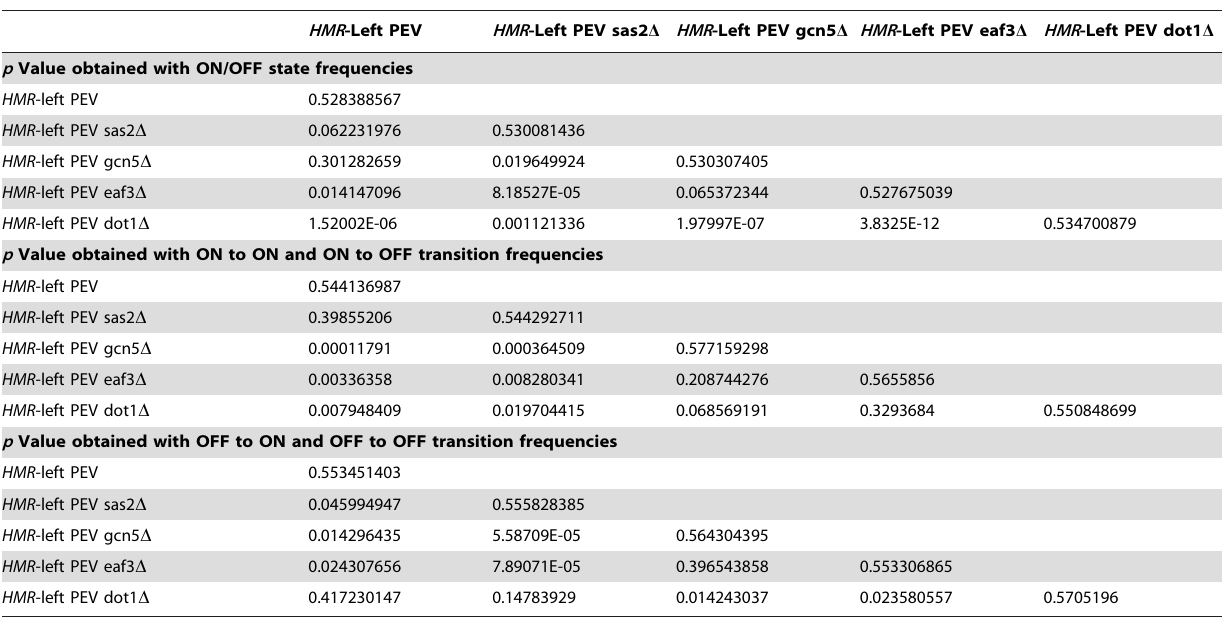
Table 4. p Values obtained with state and transition